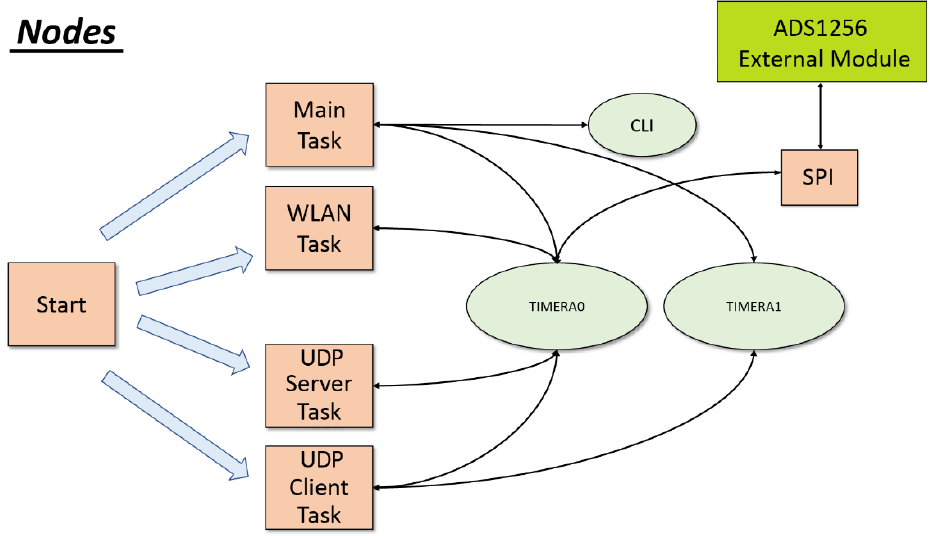
Figure 4. Block diagram of the nodes software. The main functions (square blocks) and interrupts (oval blocks) are shown and their